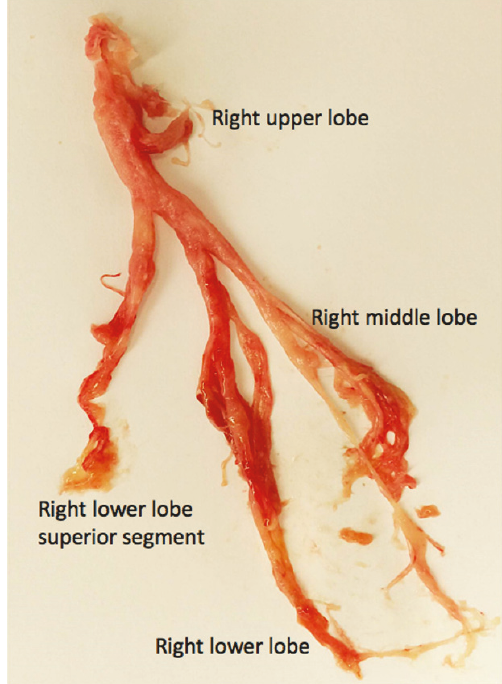
Figure 4: Bronchial cast obtained by flexible bronchoscopy fitting the mold of the right bronchial